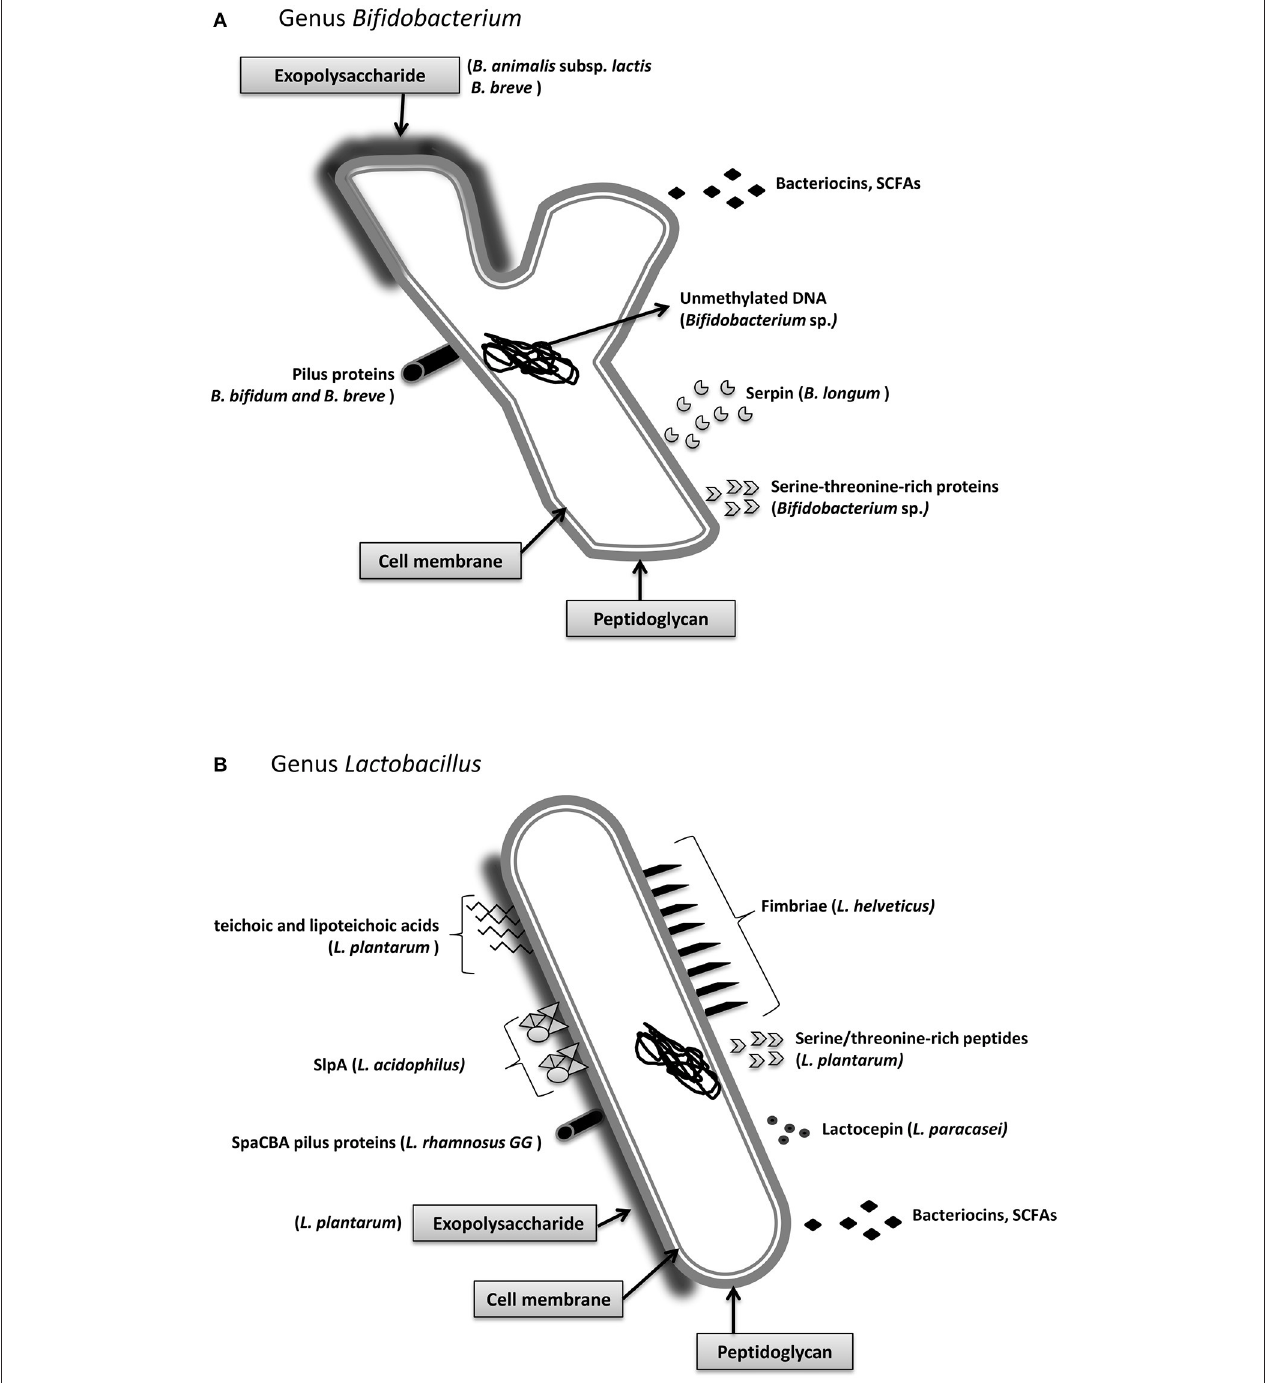
FIGURE 2 | Main molecular effectors that are able to trigger immunomodulatory responses in the host: Bifidobacterium (A) and Lactobacillus (B). Some of these effectors are species-specific, such as the S-layer protein A from Lactobacillus acidophilus , whereas others, such as short chain fatty acids, are secreted by the vast majority of strains. Detailed information about the mechanisms and the molecular effectors is included in Section Immunomodulatory Effectors.